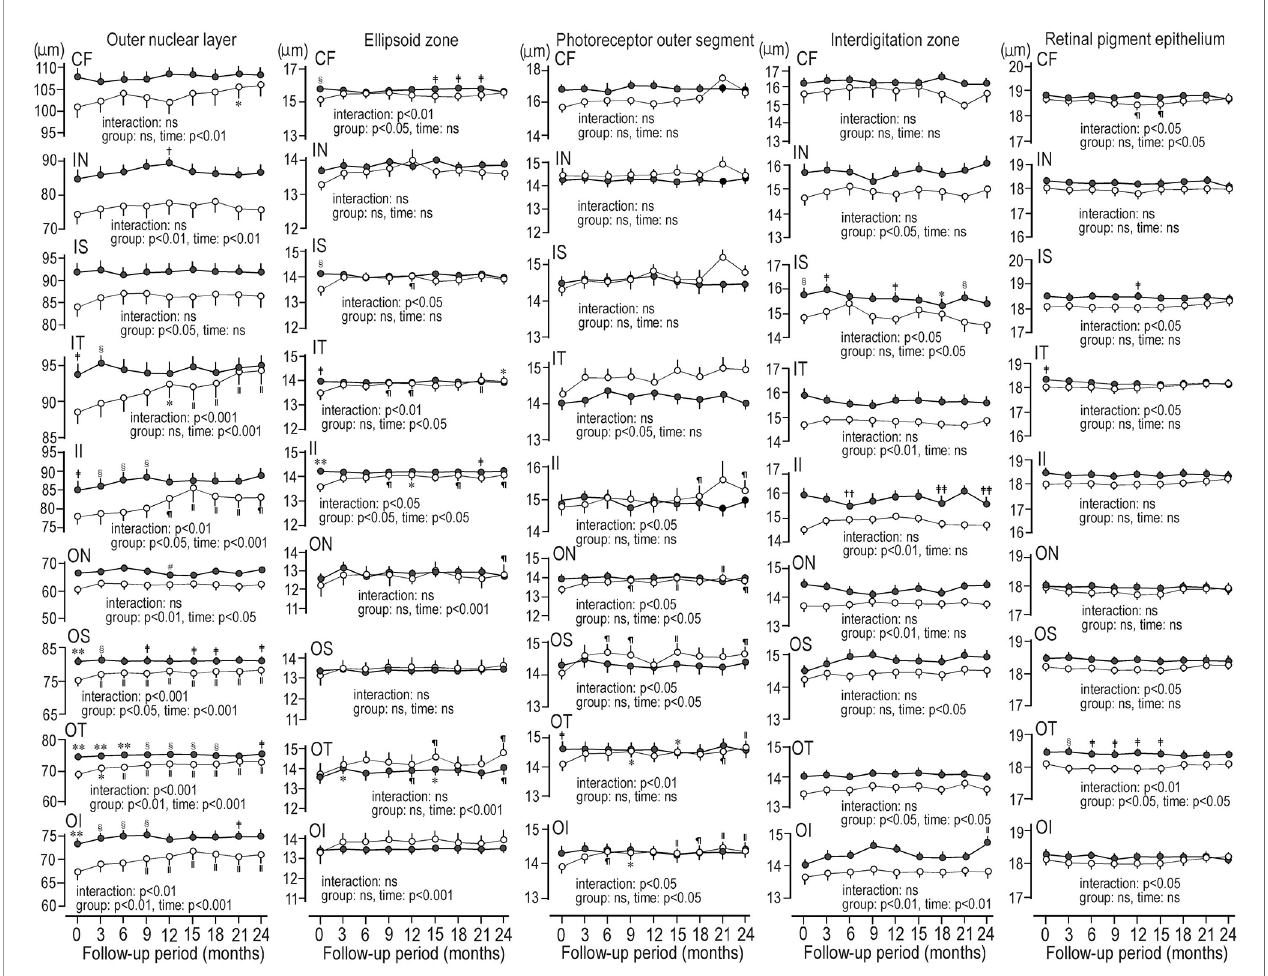
FIGURE 2 | Sequential changes for 2 years in the mean thickness at grids de fi ned by Early Treatment Diabetic Retinopathy Study of individual macular photoreceptor layers and retinal pigment epithelium in patients with type 2 diabetes undergoing glycemic control (open circle) and control subjects (solid circle). Values were mean ± SEM. *p < 0.01 compared with baseline, † p < 0.05 compared with 3 months, ‡ p < 0.05 compared with patients with type 2 diabetes, § p < 0.01 compared with patients with type 2 diabetes, װ p < 0.001 compared with baseline, ¶ p < 0.05 compared with baseline, # p < 0.05 compared with 6 months, **p < 0.001 compared with patients with type 2 diabetes, †† p < 0.01 compared with 21 months, ‡‡ p < 0.05 compared with 21 months. CF, central fovea; II, inner inferior; IN, inner nasal; IS, inner superior; IT, inner temporal; OI, outer inferior; ON, outer nasal, OS; outer superior; OT, outer